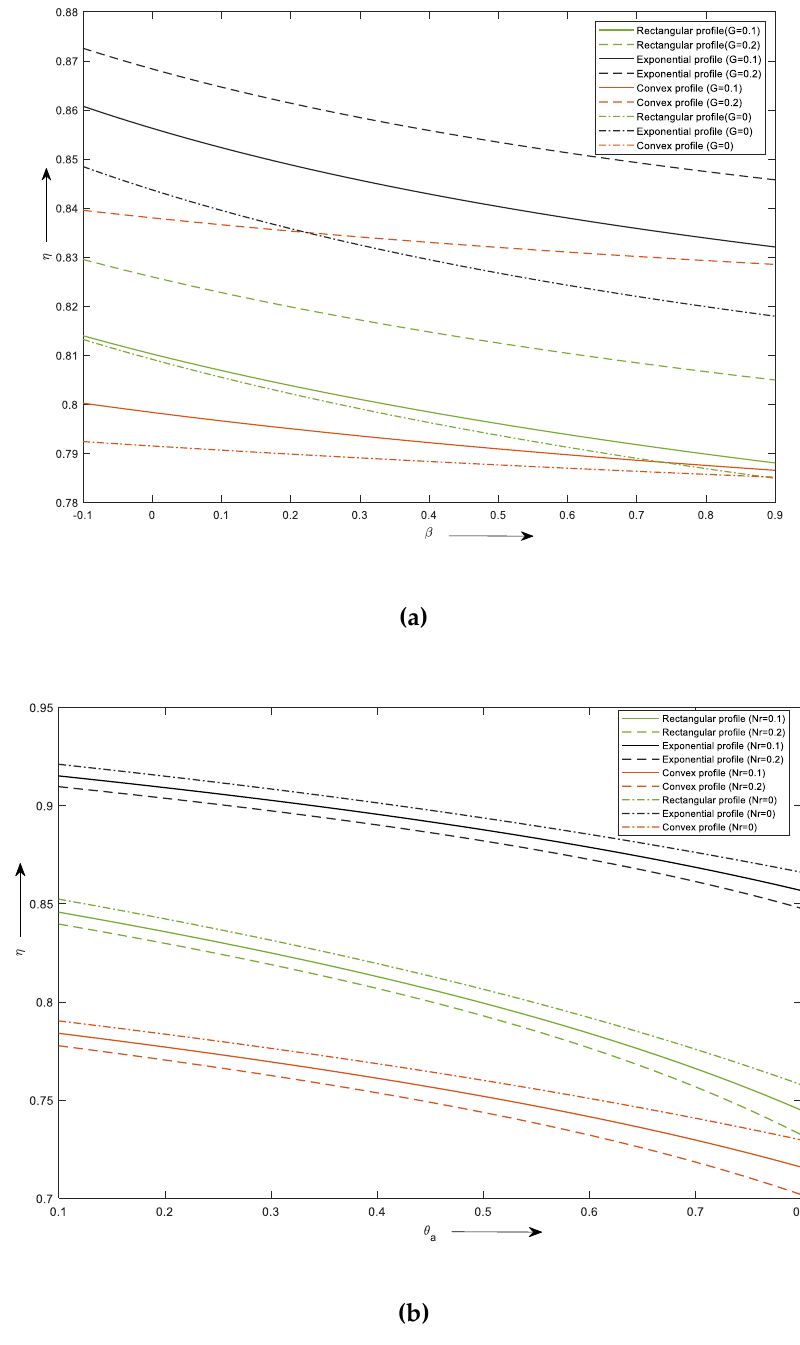
 on fin efficiency. Figure 10. Influence of: ( a ) G and β on fin efficiency; ( b ) Nr and θ a on fin a